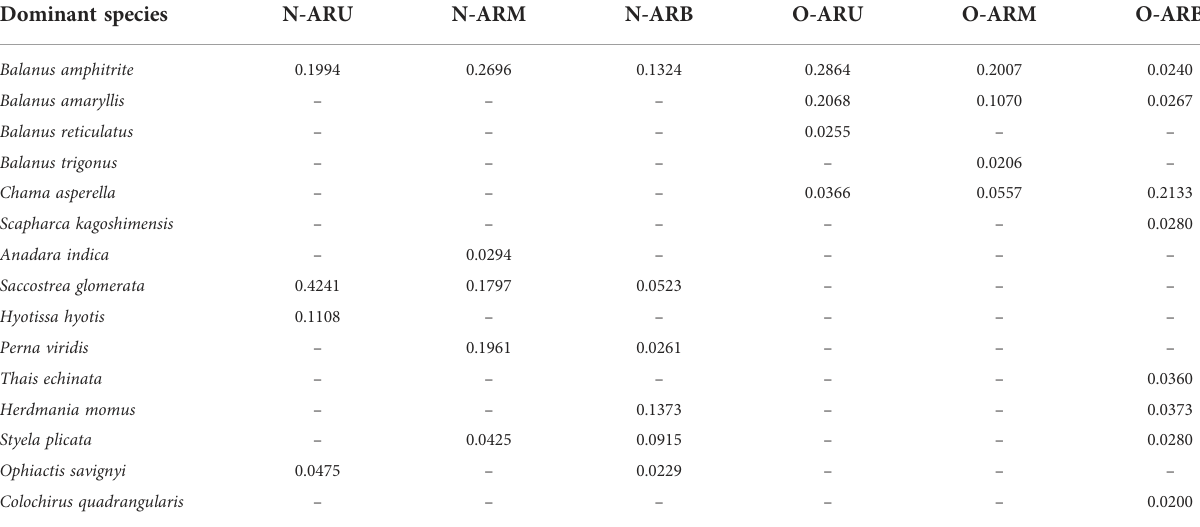
TABLE 4 Dominance of attached dominant species at each sampling